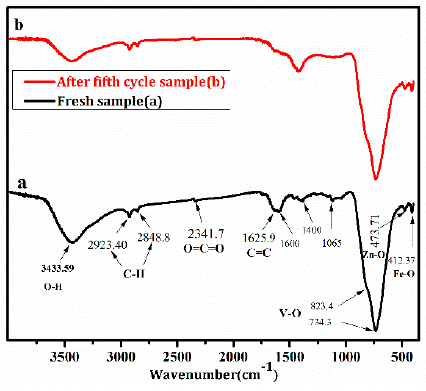
Figure 11. FTIR spectra of Mn 1-x Zn x Fe 2 O 4 /BiVO 4 /RGO ( a ) the fresh sample; ( b ) the recovered